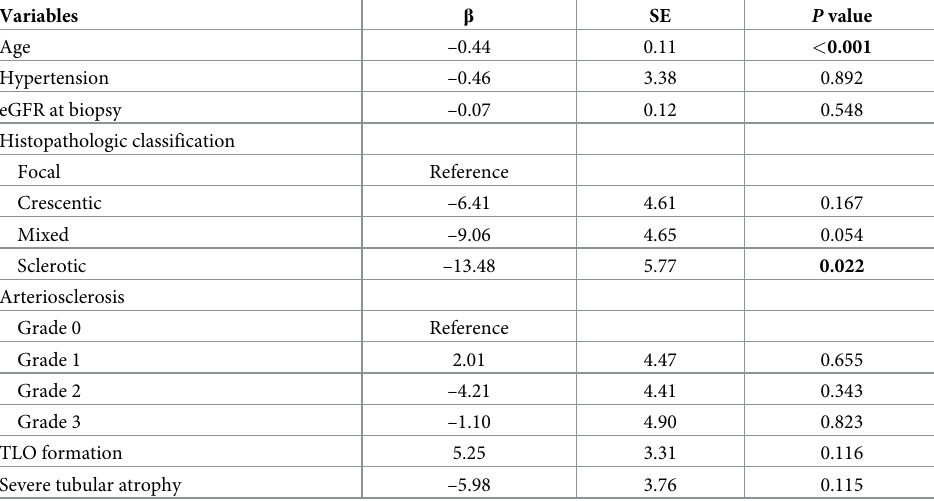
Table 2. Multivariable linear regression analysis of the change in eGFR during 1 year after